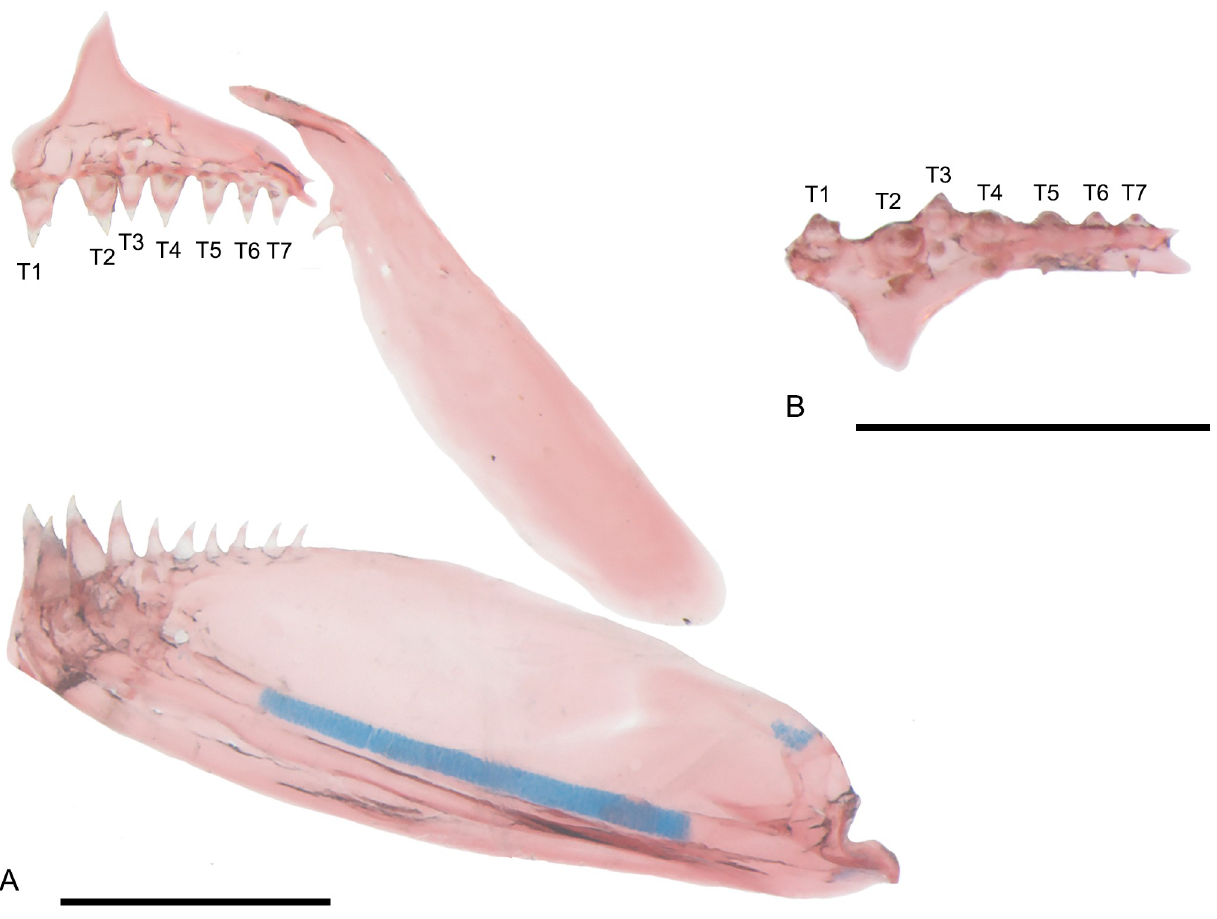
Fig 2. Jaws of Tyttobrycon shibattai MZUSP 125269, 14.6 mm SL, immature male. (A) lateral view of left side of upper and lower jaws; (B) ventral view of premaxilla, showing T1 and T3 projected outward. Symphyseal tooth (T1) and lateral most tooth (T7). Scale bar 0.5 mm. Scales cycloid. Lateral line incomplete, with 4(7), 5 � (12), or 6(1) pored scales. Longitudinal scale row, with a total of 30 � (13), 31(1), or 32(1) scales, including pored scales. Predorsal scales 9(6) or 10 � (7) in a median series. Longitudinal scales above lateral line 5 � (16); longitudinal scales row below lateral line at pelvic-fin origin 3 � (16). Single row of 1–3 scales covering base of anteriormost anal-fin rays. Scales around caudal peduncle 10 � (6). Pseudotympanum large, muscle hiatus located anterior to first pleural rib, and between first and second pleural rib. Anterior hiatus delimited by lateralis superficialis muscle dorsally and obliquus superioris muscle anteroventrally, and by first pleural rib posteriorly; posterior hiatus delimited by obliquus superioris muscle anteroventrally and by second pleural rib posteriorly (Fig 3). Supraneurals 3(4) or 5(1), rod-shaped, with proximal and distal cartilaginous tip. Dorsal- fin rays ii, 9 � (21) visible rays, plus a very small unbranched ray visible only in c&s specimens (4). First three unbranched rays in supernumerary association with first dorsal-fin pterygio- phore. Dorsal-fin middle radials as a distinct bone only in 4 th to 8 th pterygiophores; dorsal- fin distal radials mostly cartilaginous. Adipose-fin present. Pectoral-fin rays i, 10 � (21), reaching beyond pelvic-fin origin when adpressed. Pelvic-fin rays i, 7 � (21). Pelvic-fin origin anterior to vertical through dorsal-fin origin. Anal fin with 3(3) or 4(1) unbranched rays in